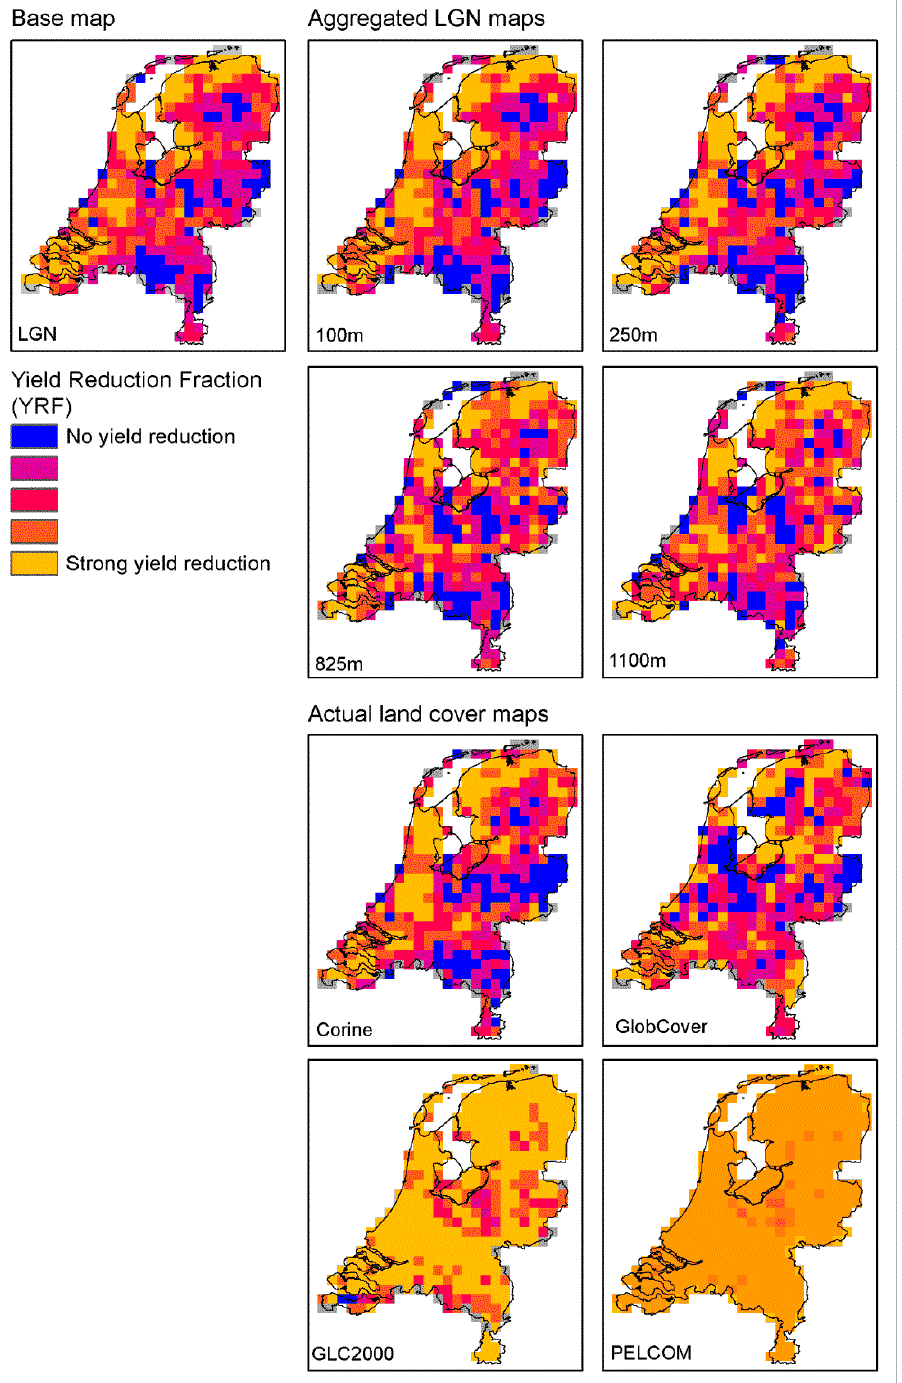
Figure 5. Yield reduction fractions. ( Top left ) Base map; ( Top ) Maps based on aggregated LGN; ( Bottom ) Maps based on real land